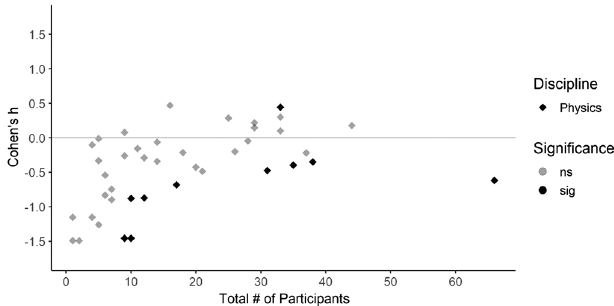
FIG. 3. Examining individual classroom observations for gen- der equity. Each point represents a binomial test evaluating whether the observed proportion of men individually participat- ing verbally in class differs from the proportion of men on the roster. Cohen ’ s h represents effect size, or the distance between the expected proportion (based on the course roster) and the observed proportion of men participating. A Cohen ’ s h greater than zero indicates that women participated at higher levels than expected, while a Cohen ’ s h less than zero indicates that men participated at higher levels than expected. Significance is denoted by color: the 10 (out of 42) significant tests are black, and the nonsignificant tests are gray.